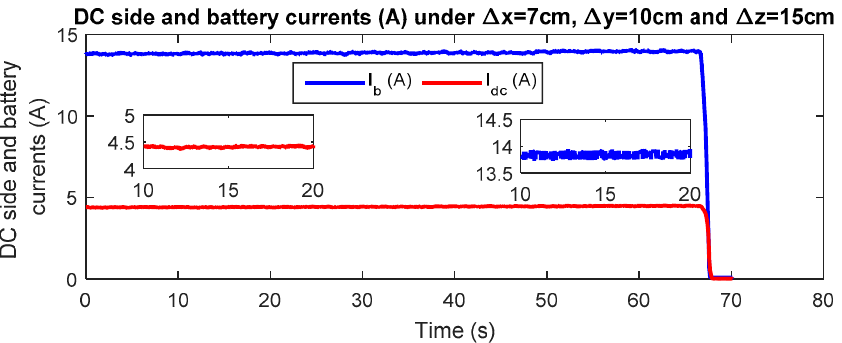
Figure 33. Variations of the DC-side and battery currents in the presence of lateral and vertical misalignments (Vdc = 200 V, ∆ x = 7 cm, ∆ y = 10 cm and ∆ z = 15 cm).